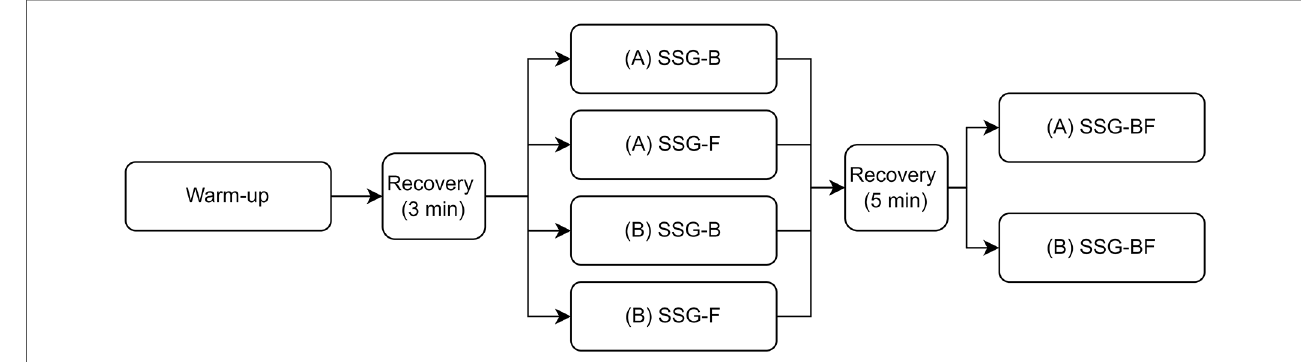
FIGURE 1 Structure of each day of data